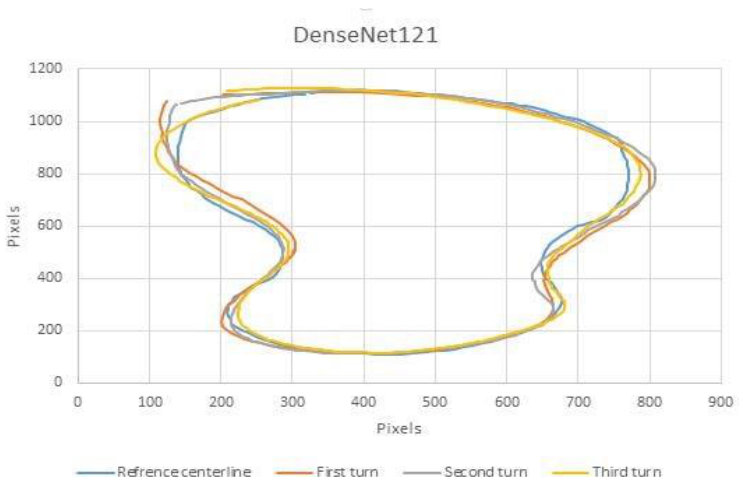
Fig. 8. The drawn paths for three full laps on both tracks using ResNet18 and DenseNet121. (a) The drawn paths of ResNet18 on the first track. (b) The drawn paths ResNet18 model on the second track. (c) The drawn paths of the DenseNet121 Model on the first track. (d) The drawn paths DenseNet121 model on the second track. Table 2, The dissimilarity between curves and centerline using discrete Frechet distance. First track Second track Num of turns ResNet18 DenseNet121 ResNet18